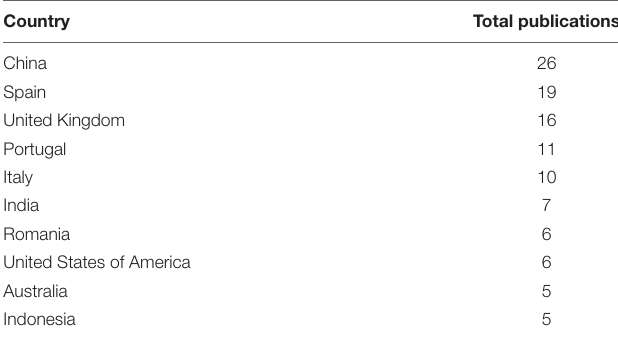
TABLE 5 | Top countries in